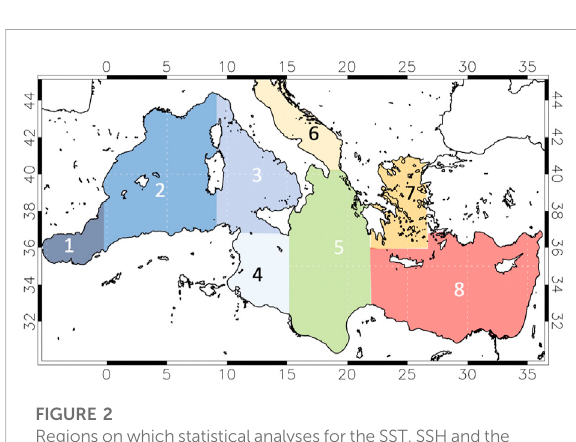
FIGURE 2 Regions on which statisticalanalysesfor theSST, SSH and the hydrological variables have been carried